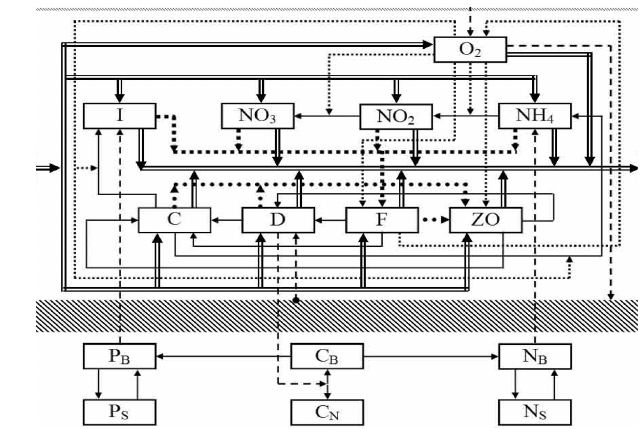
Figure 7. A scheme of biochemical transformation of aquatic ecosystem components.